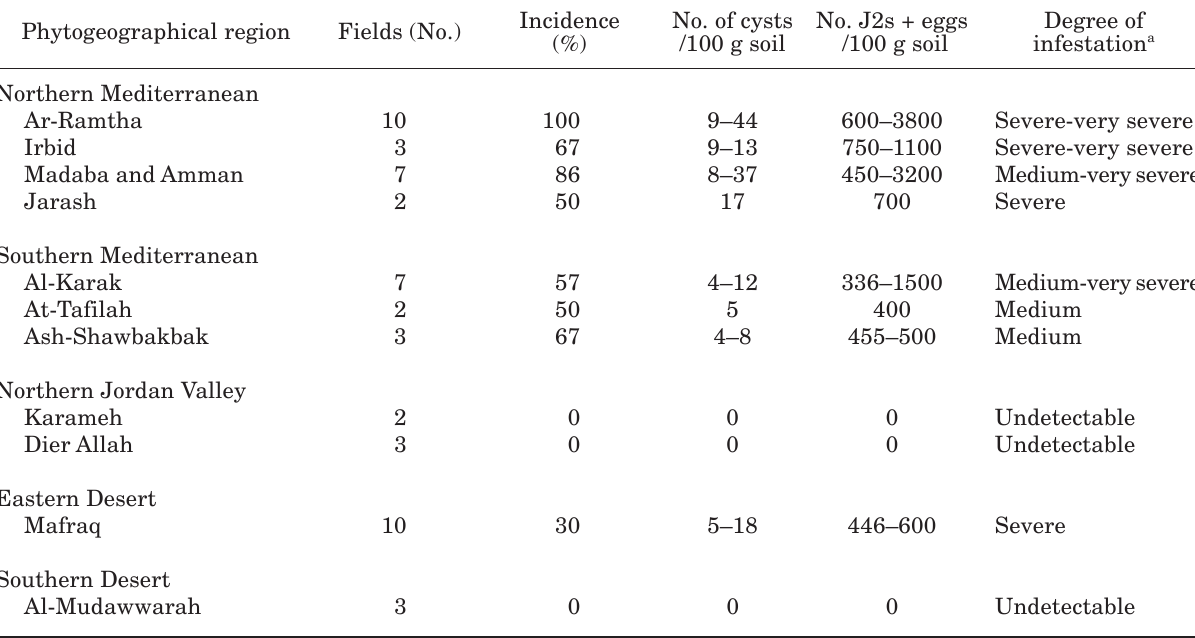
Table 1. Occurrence and degree of infestation of Heterodera latipons in the major barley producing regions, in Jordan, during 1999–2000. Phytogeographical region Fields